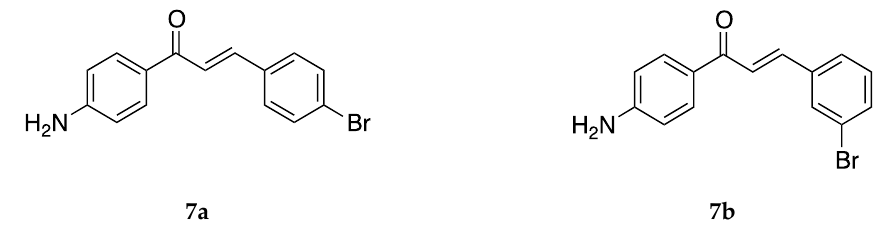
Figure 9. Chemical structures of 4-aminochalcone derivatives with bromo substitutions on ring B. Both 7a and 7b were also tested against the estrogen-receptor-positive breast cancer cells MCF-